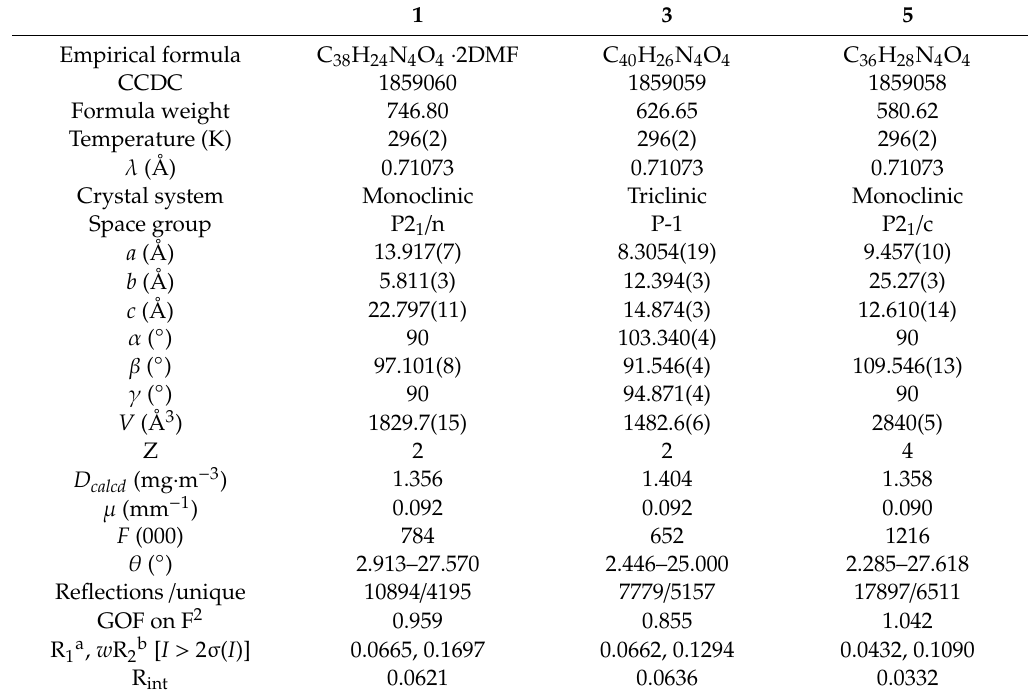
Table 1. Crystallographic data for 1 , 3 , and 5 .